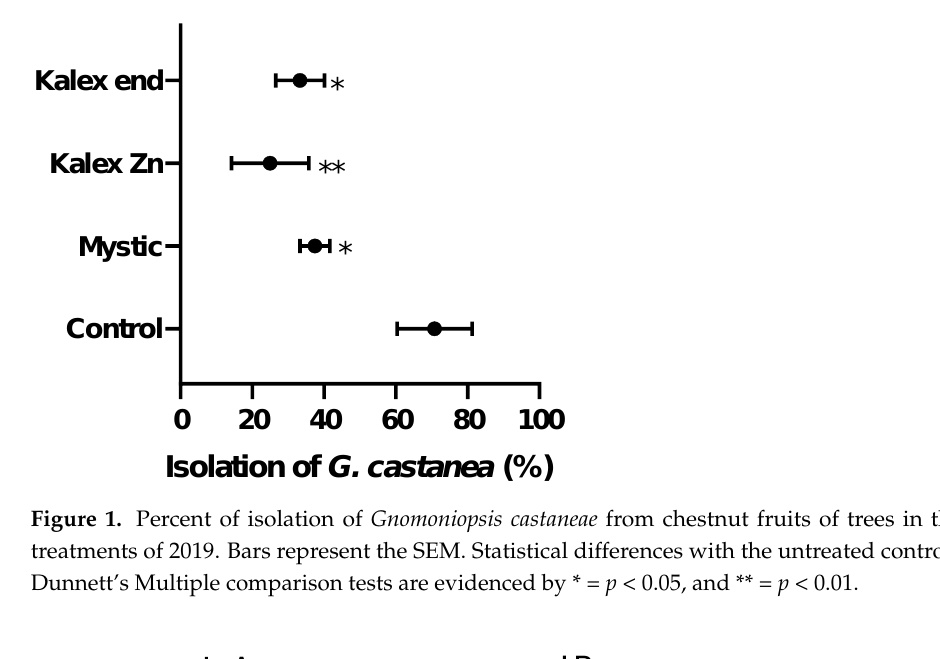
Figure 1. Percent of isolation of Gnomoniopsis castaneae from chestnut fruits of trees in the four treat- ments of 2019. Bars represent the SEM. Statistical differences with the untreated control at the Dun- nett’s Multiple comparison tests are evidenced by * = p < 0 . 05, and ** = p < 0 . 01.